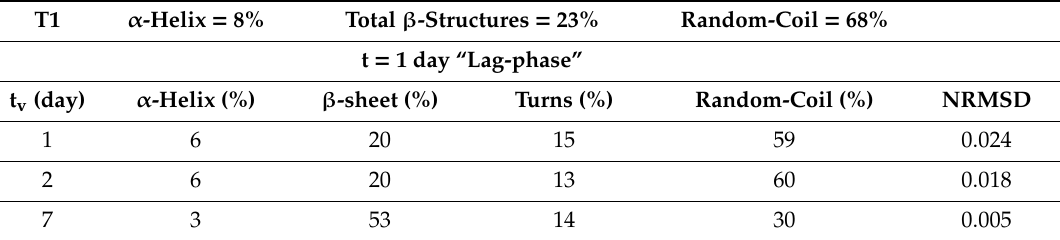
Table 2. Percentage of the sCT secondary structures obtained by the CD spectrum relative to sCT representing the “Lag-phase” (T1) solution, before and after the interaction with DPPC / Chol / GM1 (spectra of Figure 5).